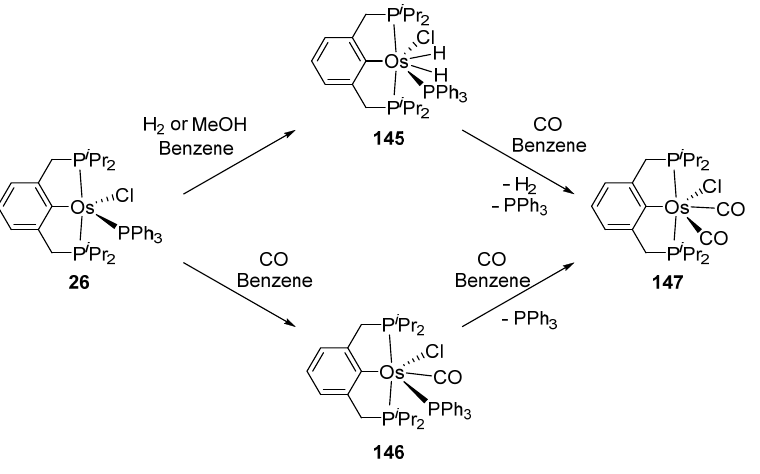
Figure 31. Reactions of P~C~P pincer complex 26 with H 2 and CO.